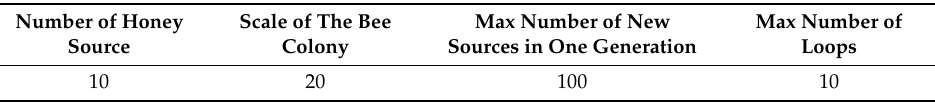
Table 8. Parameters preset in ABC.